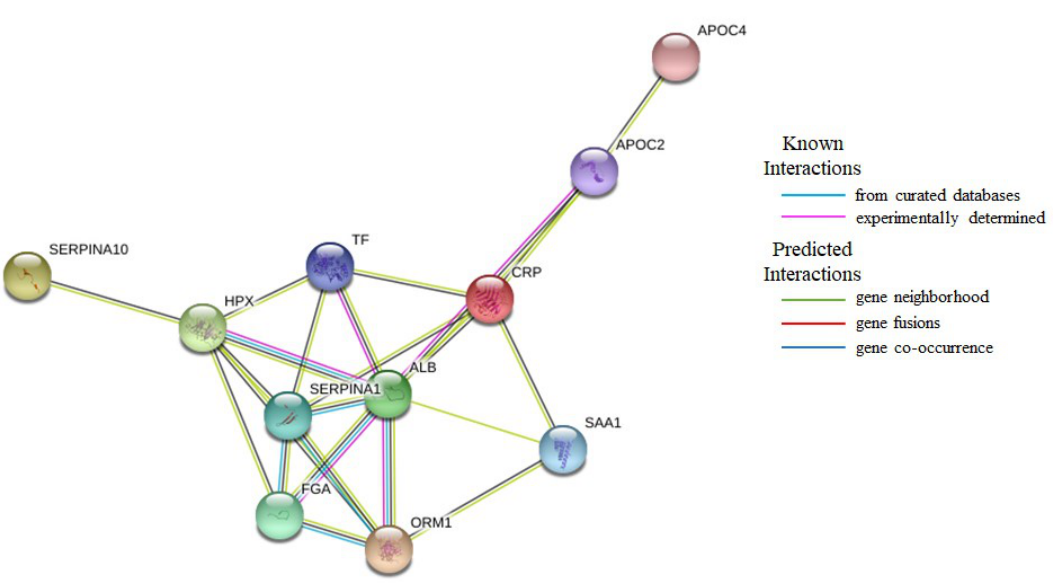
Figure 4. Interaction network of proteins identified as differentially expressed using iTRAQ analysis (source: https://string-db.org): C-reactive protein (CRP), Fibrinogen alpha chain (FGA), Apolipoprotein C-II (APOC2), Apolipoprotein IV (APOC4), Serum amyloid A1 protein (SAA1), Alpha-1-acid glycoprotein 1 (ORM1), Alpha-1-antitrypsin (SERPINA1), Hemopexin (HPX), Serotransferrin (TF), Protein Z-dependent protease inhibitor (SERPINA10) and Serum albumin